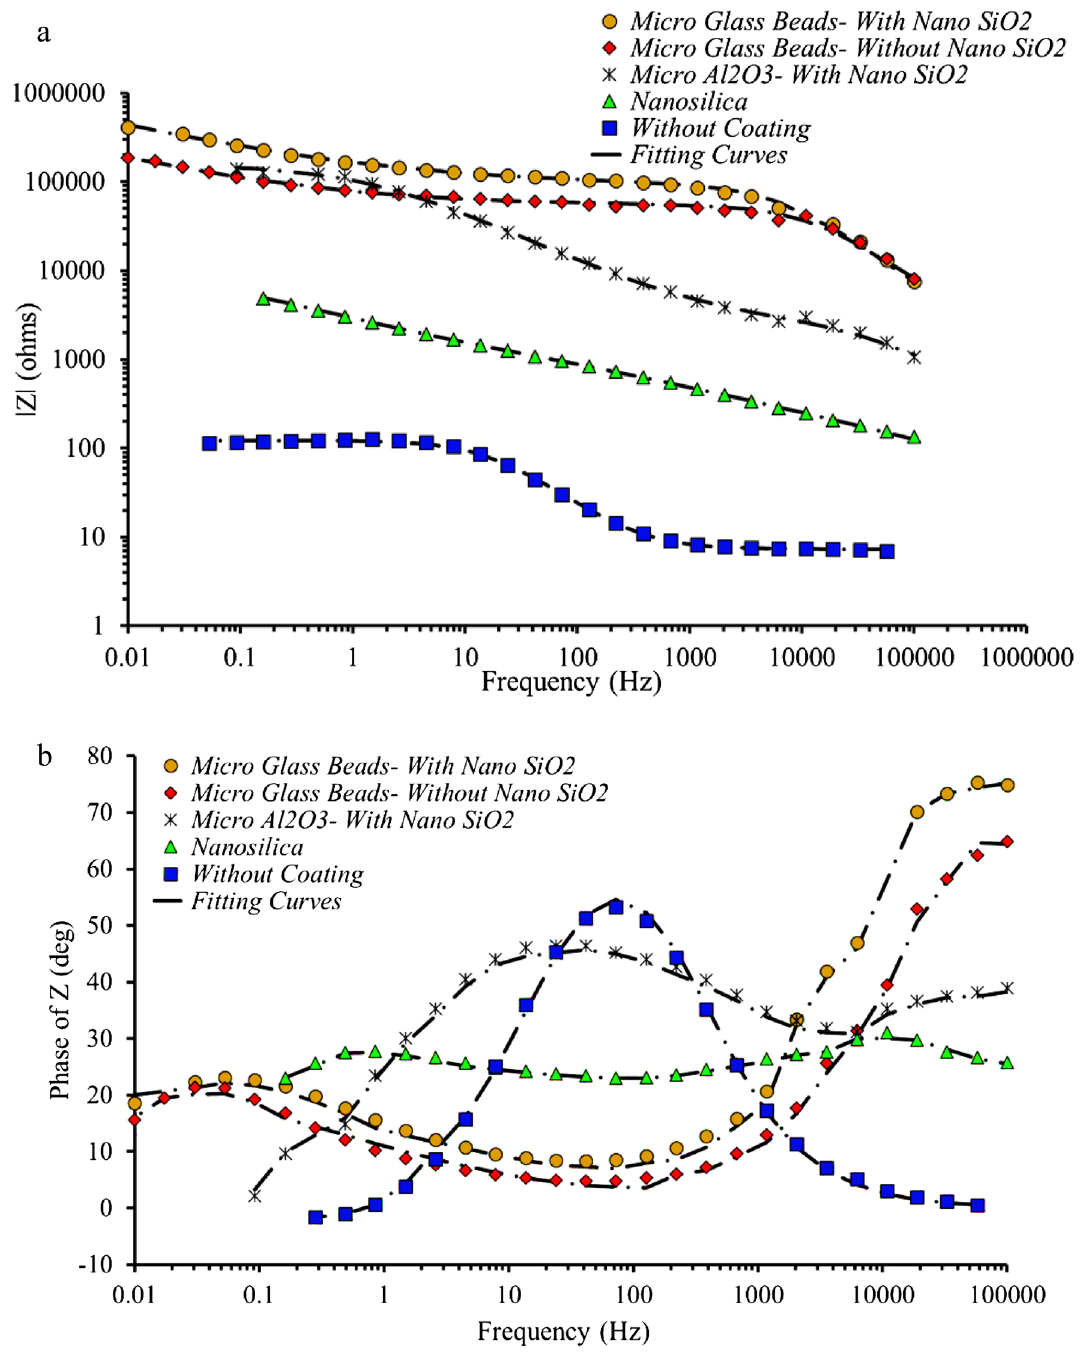
Figure 7. Bode ( a ) and Bode-phase ( b ) plots from EIS data of PTFE coating with glass beads microparticles in primer layer and SiO 2 nanoparticles in overcoat layer (circle symbols), PTFE coating with glass beads microparticles in primer layer and without SiO 2 nanoparticles in overcoat layer (diamond symbols), PTFE coating with Al 2 O 3 microparticles in primer layer and SiO 2 nanoparticles in overcoat layer (star symbol), nanosilica coating (triangle symbols), and uncoated sample (square symbols). Impedance spectra contain experimental data (scatter plot marked by symbols) and theoretical fitting curves (lines), which simulate the experimental results by means equivalent electrical